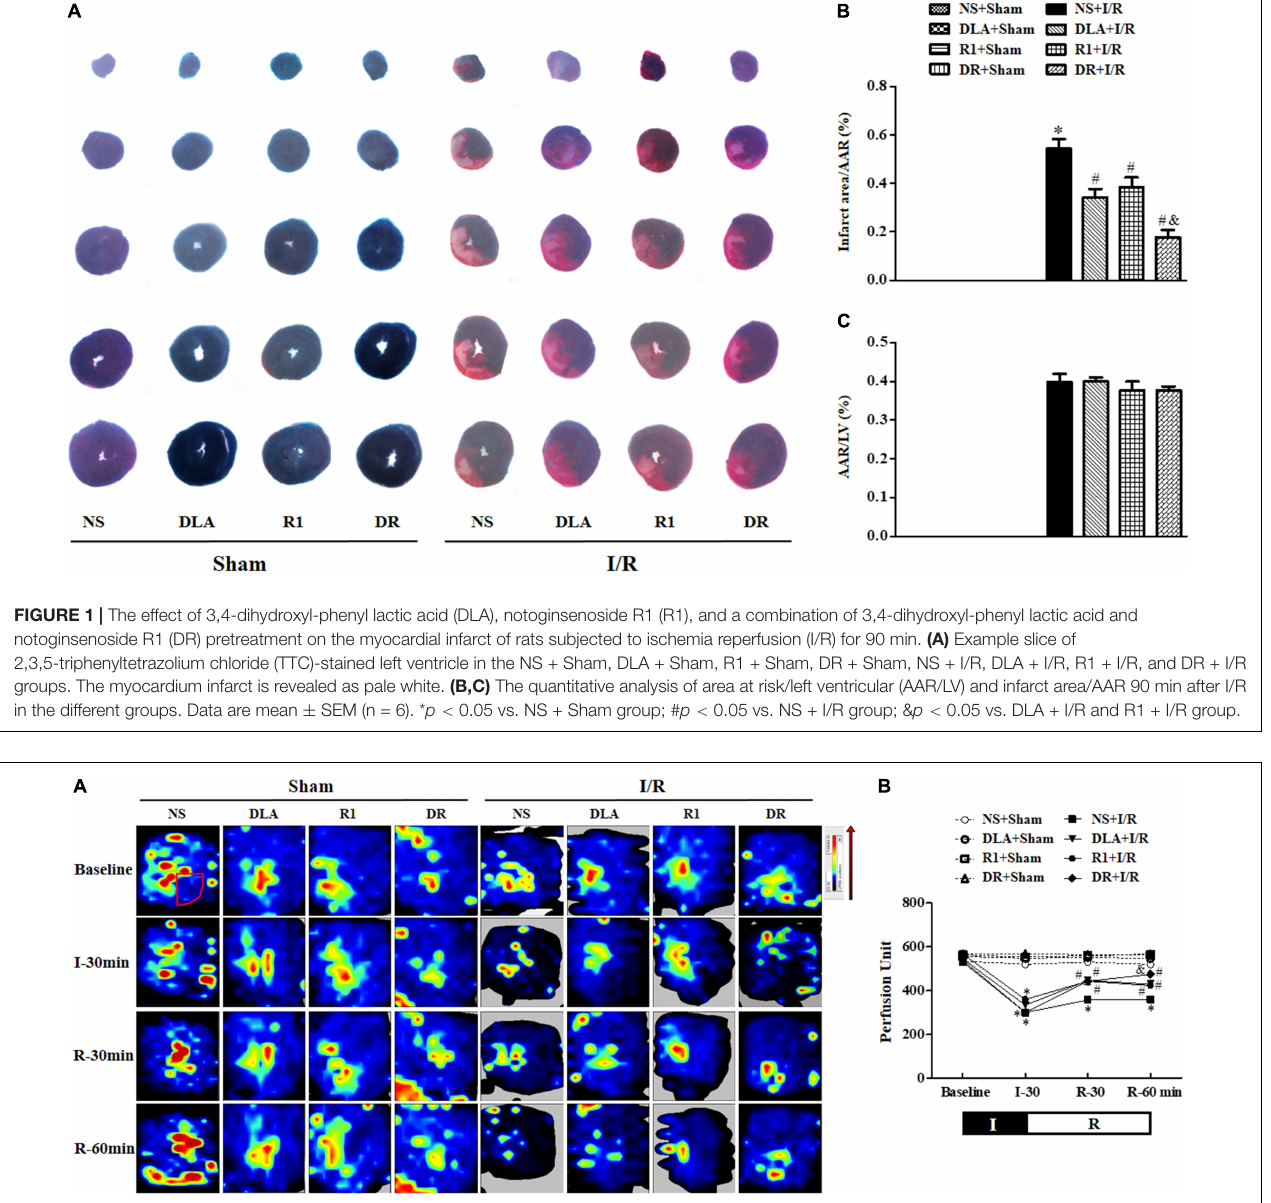
FIGURE 2 | The effect of DLA, R1, and DR pretreatment on myocardial blood flow (MBF) of rats after I/R. (A) The MBF images acquired by a Laser-Doppler Perfusion Imager in the NS + Sham, DLA + Sham, R1 + Sham, DR + Sham, NS + I/R, DLA + I/R, R1 + I/R, and DR + I/R groups at baseline and 0, 30, and 60 min after reperfusion. Flux is represented by a color scale (from dark blue to red denoting low to high flux). The area within the box showed the location of the left ventricle where the blood flow was detected and quantified. (B) Time course of changes in MBF in different conditions. Data are mean ± SEM (n = 6). I, ischemia phase; R, reperfusion phase. * p < 0.05 vs. NS + Sham group; # p < 0.05 vs. NS + I/R group; & p < 0.05 vs. DLA + I/R group and R1 + I/R